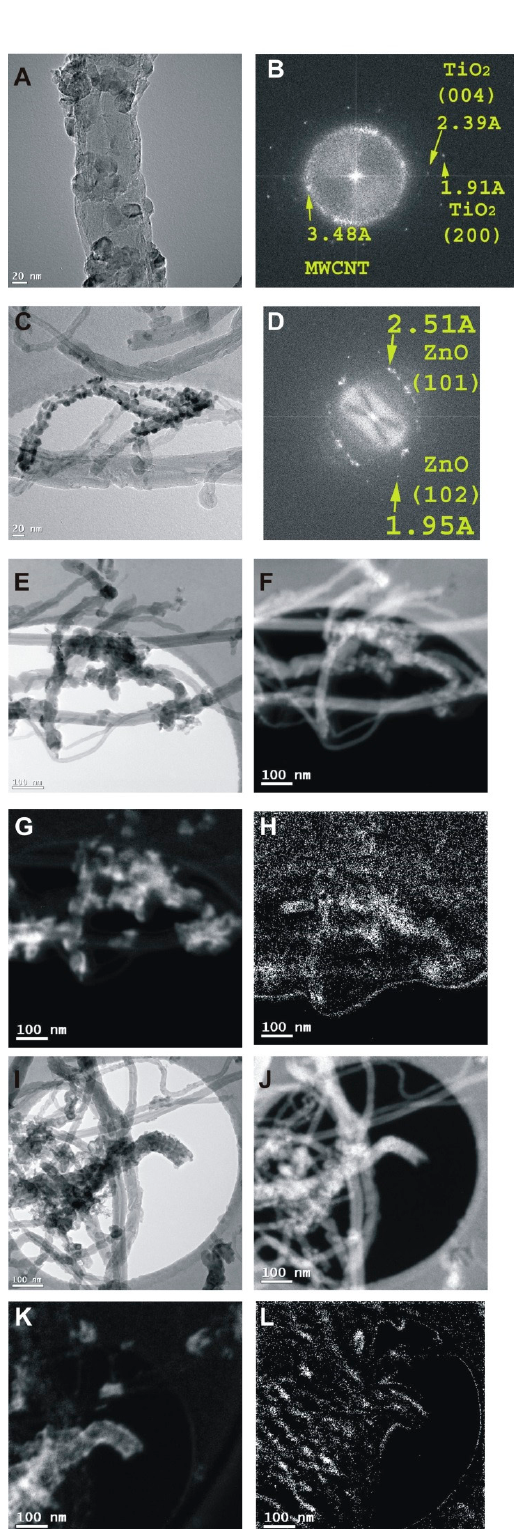
Figure 5. TEM ( A ) and FFT ( B ) of images of the CNT-TiO 2 sample; TEM ( C ) and FFT ( D ) of images of the CNT-ZnO sample; TEM ( E ) image and C ( F ), Ti ( G ) and Zn ( H ) EELS maps of the CNT-TiO 2 -ZnO sample; TEM ( I ) image and C ( J ), Ti ( K ) and Zn ( L ) EELS maps of the CNT-ZnO-TiO 2 sample . The FFT of a TEM image has the same informational content as a SAED pattern (and is similar in appearance) from the same